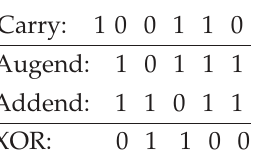
Figure 2: Carry generated in i th column is saved in (cid:2) i (cid:7) 1 (cid:3) th column for i (cid:4) 0 , 1 , 2 ,...,n